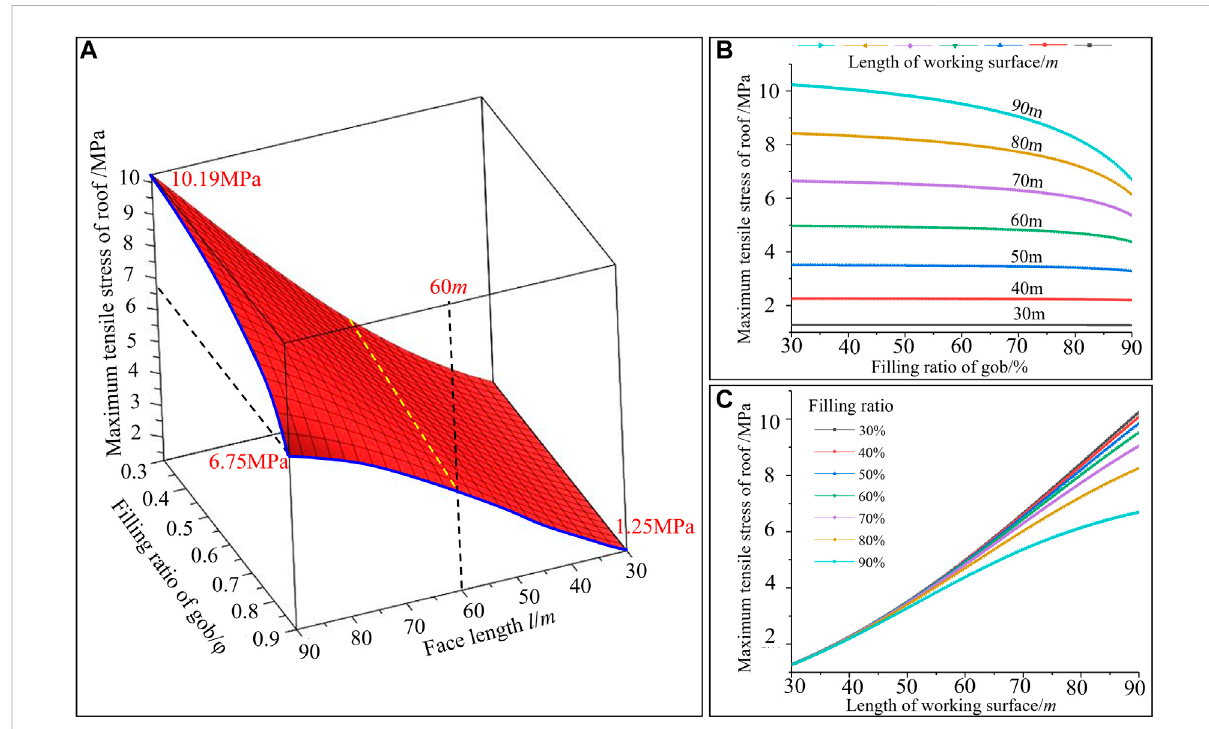
FIGURE 4 In fl uencingfactors ofmaximumtensilestressofroof, (A) The relationship betweenthemaximum tensilestressoftheroofandthelengthofthe working face and the fi lling rate, (B) Filling rate, (C) Length of working